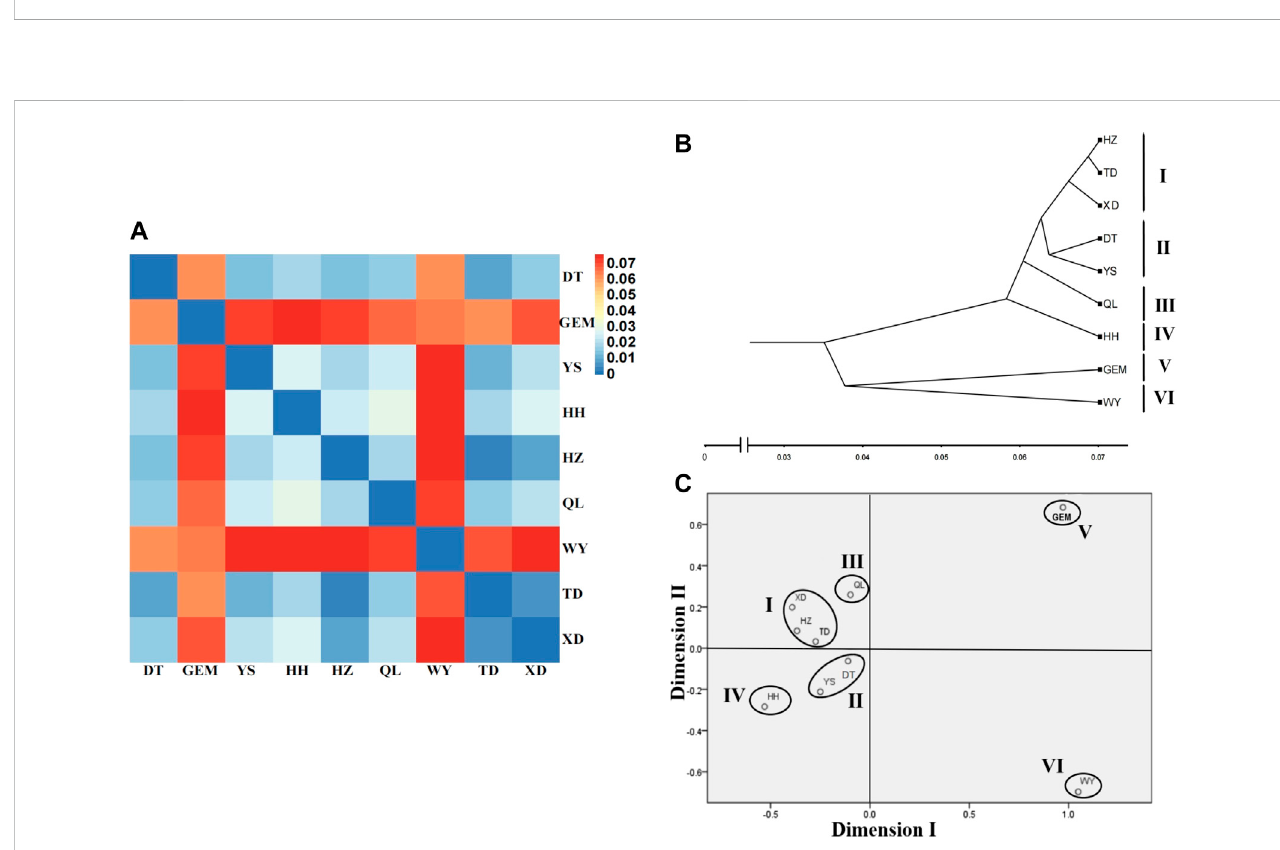
FIGURE 4 Genetic relationships among Qinghai yak breeds/populations. (A) Heat map of genetic differentiation among nine yak breeds/populations. (B) Cluster relationship among nine yak breeds/populations using the UPGMA tree. (C) MDS analysis among nine yak breeds/populations.